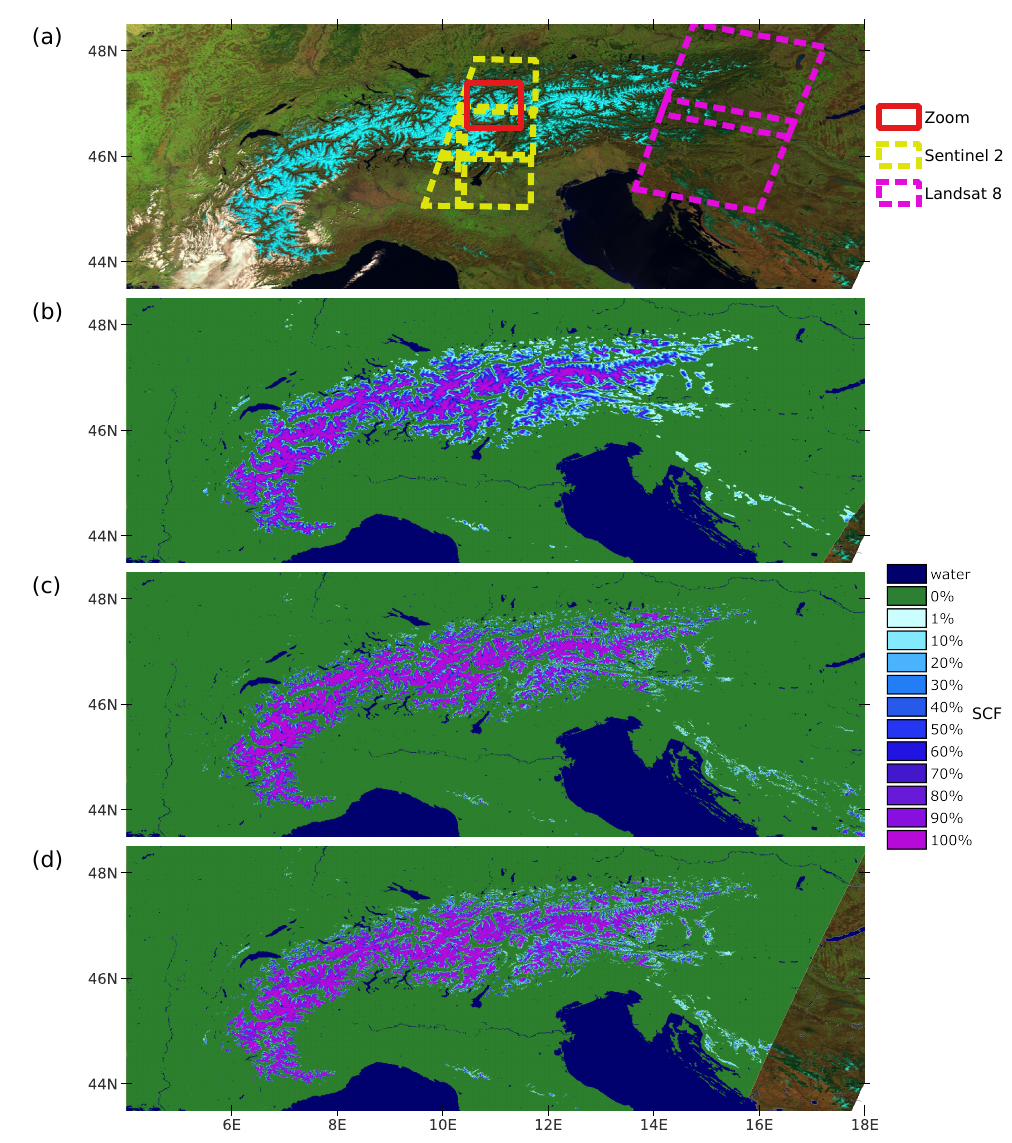
Figure 9. Example over the Alps on 2 April 2020 from ( a ) Sentinel-3B SLSTR false colour composite (bands 5, 3 and 2). ( b ) LAMSU SCF derived from Terra MODIS data at 1000 m. ( c ) LAMSU SCF derived from Suomi NPP VIIRS data at 500 m. ( d ) LAMSU SCF derived from Sentinel-3B SLSTR and OLCI data combined at 250 m. An enlarged section is presented in Figure A7, which covers the red box in subfigure ( a ). The yellow and purple dashed boxes in subfigure ( a ) illustrate the extent of the comparison with high-resolution snow maps from Tables 4 and